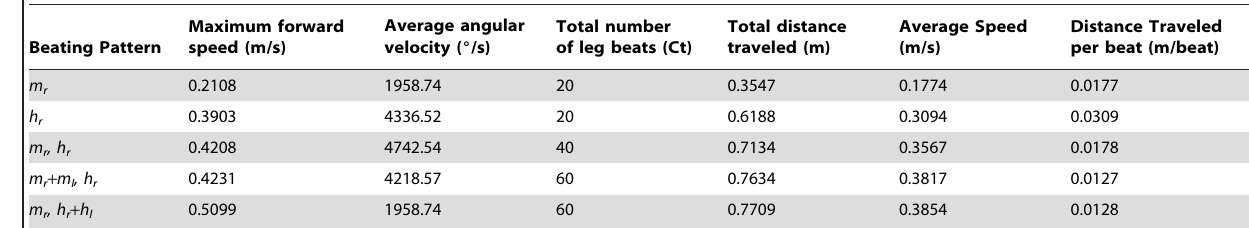
Table 5. Analysis of circling